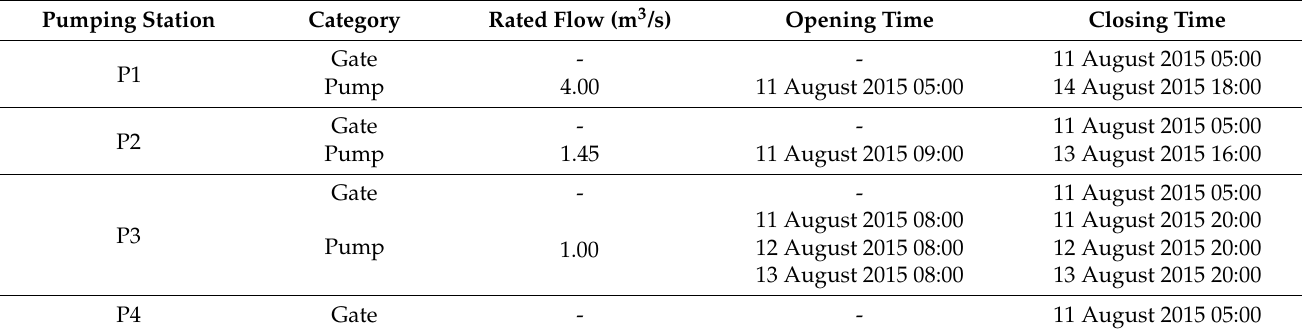
Table 2. Actual scheduling strategy of waterlogging drainage engineering (Rainfall Event 2).